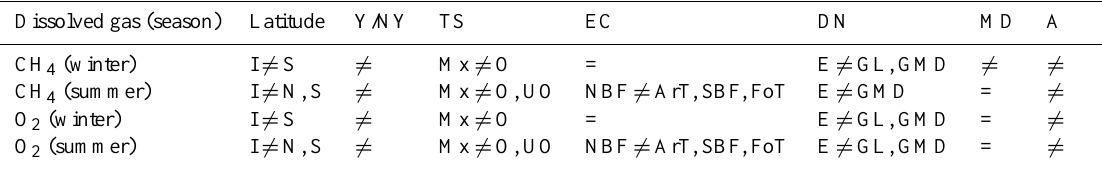
Table 5. Mann–Whitney and Kruskal–Wallis test results for the relationships between limnological and geographic characteristics of lakes vs. dissolved gas concentrations (CH 4 or O 2 ) during winter and summer. “ (cid:54)= ” indicates a significant difference between a geographic characteristic and flux when Z > 1 . 96; “ = ” indicates no significant difference. Latitude: I – interior, N – northern, and S – southern according to Sect. 2.1; permafrost soil type (Y/NY – yedoma/non-yedoma); trophic state index (TSI), ecozonal categories (EC), and deposit type (DN) according to descriptions in Table 1; maximum depth known (MD) and area (A). In the MD analysis we considered two categories: shallow lakes ≤ 2.5m and deeper lakes > 2.5m. In the A analysis we considered two categories: small lakes ≤ 0.1km 2 and large lakes > 0.1km 2